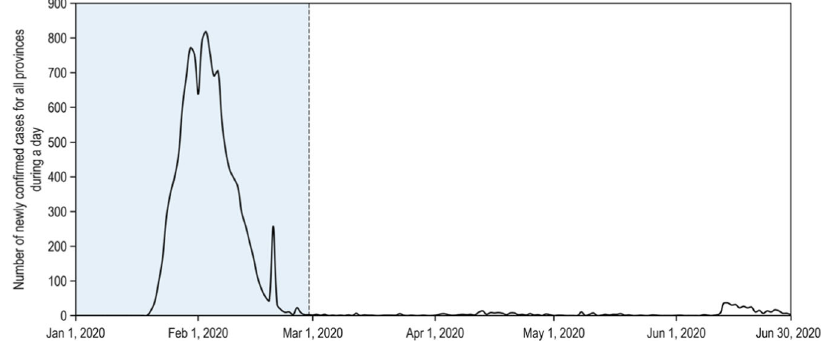
Fig. 1 Daily newly con fi rmed cases of infection. The number of daily newly con fi rmed cases of infection in thirty provinces (excluding Hubei province where the city of Wuhan is located) of mainland China during January – June